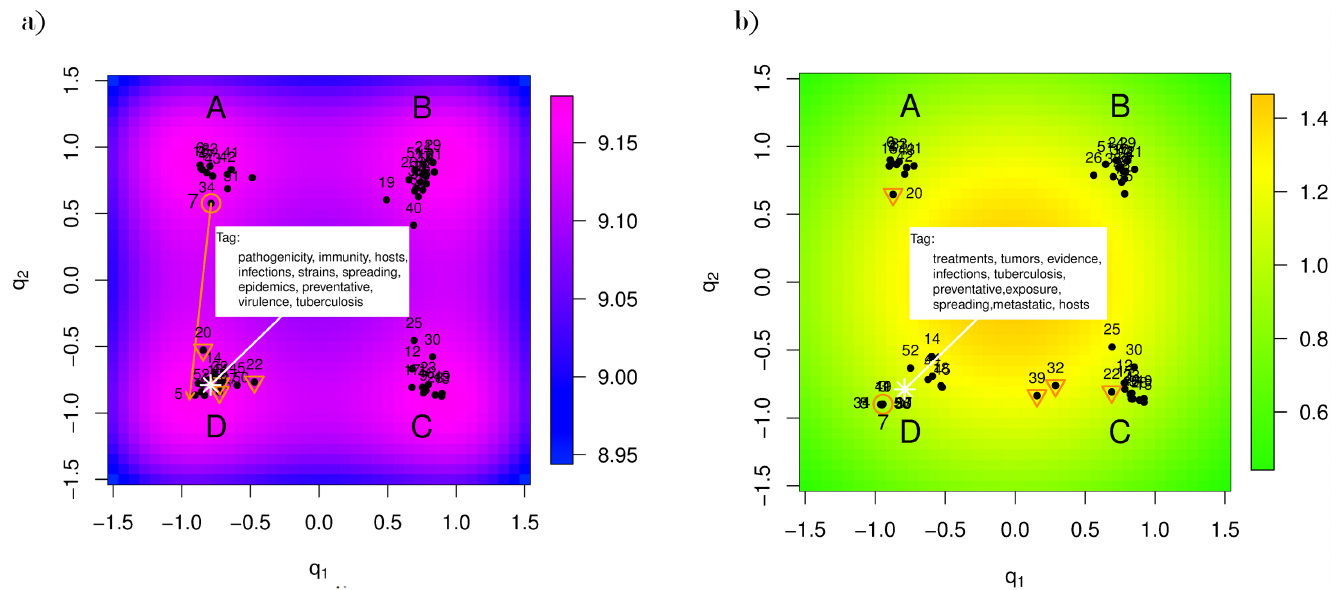
Fig 4. V2PI-GTM with NIH data. We provide a GTM display of the NIH abstracts (labeled by their identification numbers) before and after user interaction in Figs a and b, respectively. The interaction is portrayed by the pink arrow in Fig a; Abstract 7 was moved to a location near cluster D. In addition, to labeling and learning about four clusters in the data (marked by A, B, C, and D), we also tagged the latent GTM space. After the interaction, we see that the clusters grouped differently and the meaning of the latent space changed. Also, the manifold changed